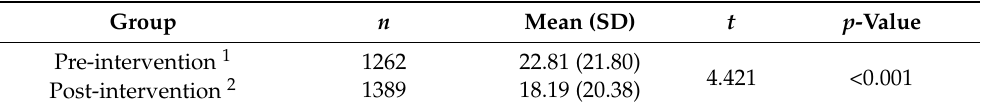
Table A2. Student’s t -test results of the time (hours) required to order TPN by ward physicians for patients with NST referrals during the pre- and post-intervention